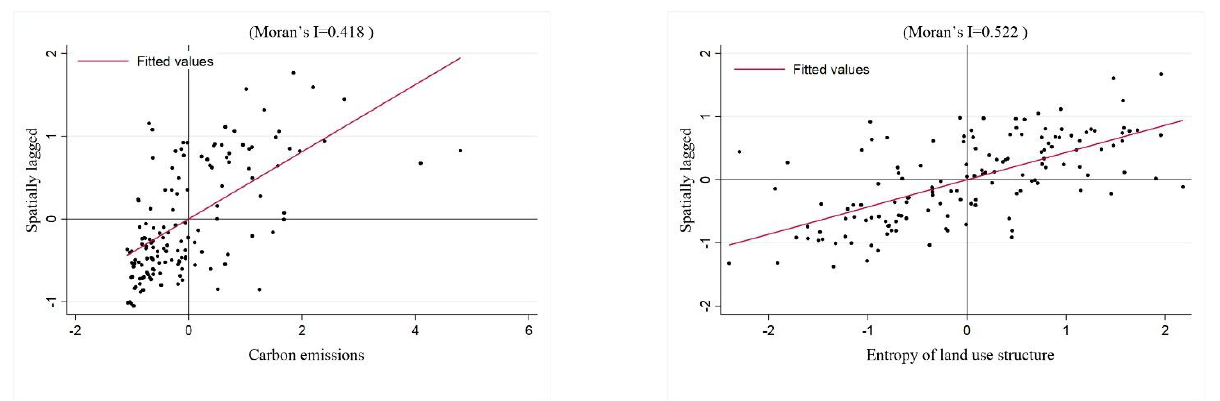
Figure 9. Moran’s I of carbon emissions and information entropy of land use structure: 2000 − 2018.